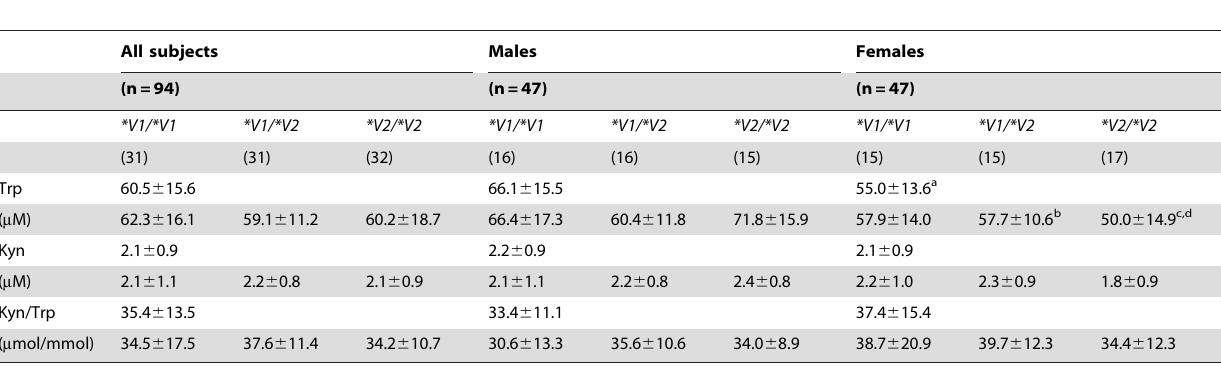
Table 3. Mean serum concentrations ( 6 S.D.) of tryptophan (Trp), kynurenine (Kyn) and Kyn/Trp ratio in 94 healthy Caucasian subjects according to their IDO1 VNTR